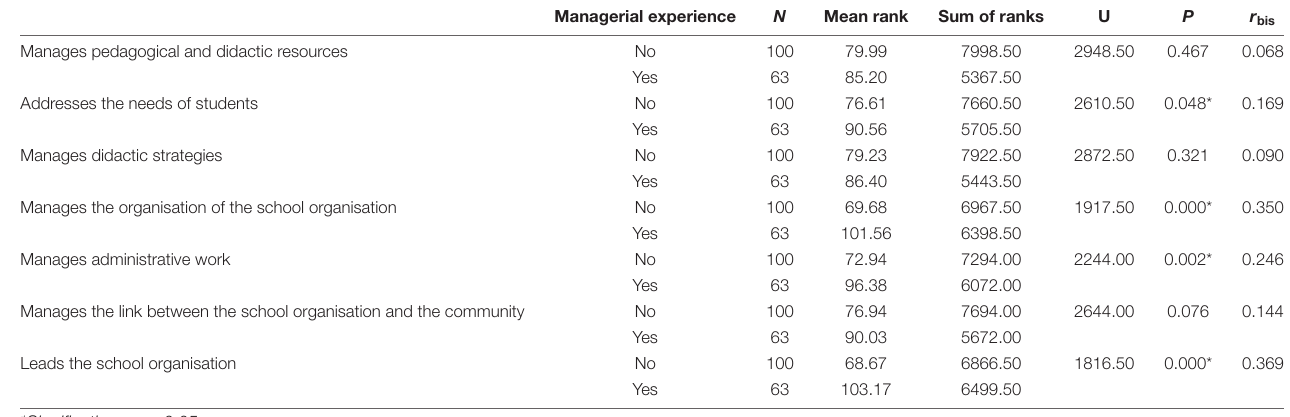
TABLE 5 | Results of Mann-Whitney U test managerial experience vs. no managerial experience in dimensions.